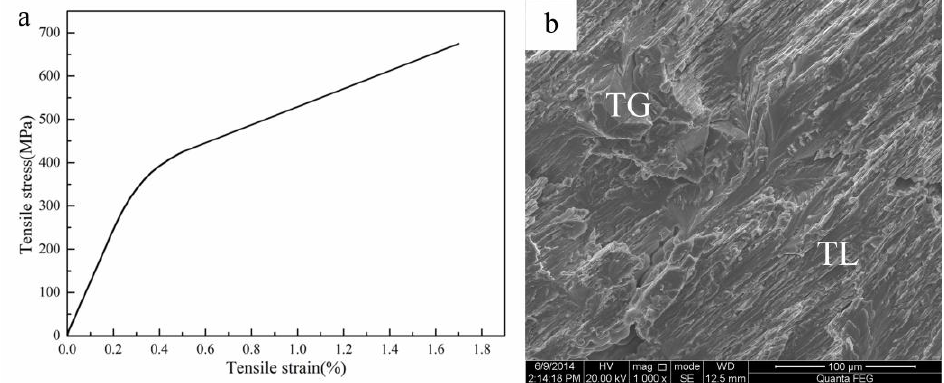
Figure 8. Tensile test stress-strain curve obtained at room temperature ( a ) and fracture surface ( b ) of as-cast TiAl specimen, transgranular (TG) and translamellar